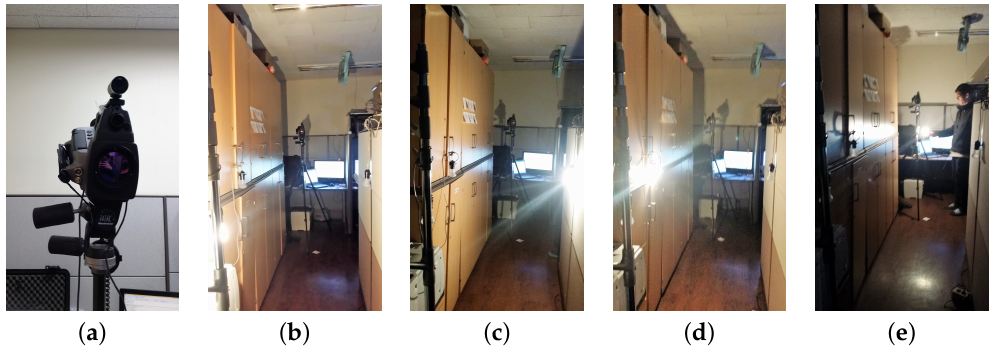
Figure 9. Configuration of data acquisition by a thermal camera and a visual camera, and different lighting conditions of the environmental configurations. ( a ) Configuration of data acquisition by a thermal camera and a visual camera; and the different environments of ( b ) back; ( c ) left; ( d ) right; and ( e ) front side